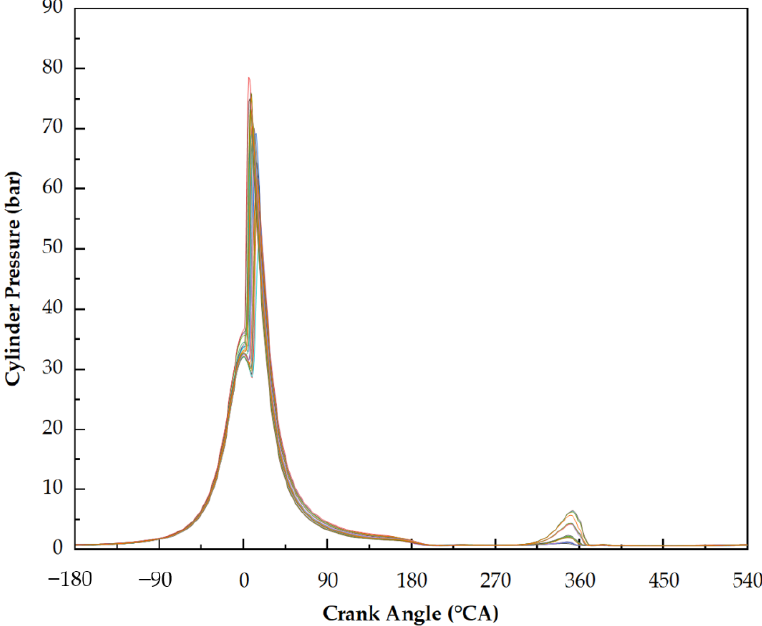
Figure 10. The cylinder pressure curves of intake port EGR type HCCI combustion at 1000 rpm.